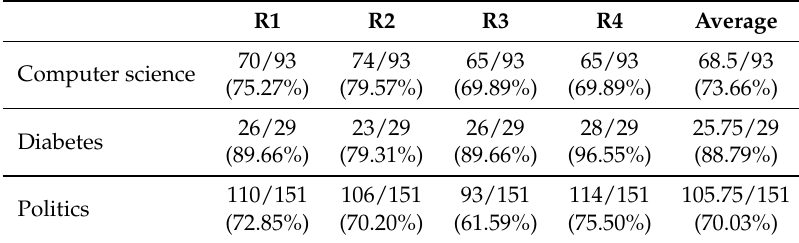
Table 10. Harvest rate values for Google seed URLs per rater. R1 is for rater 1, R2 is for rater 2, etc. R1